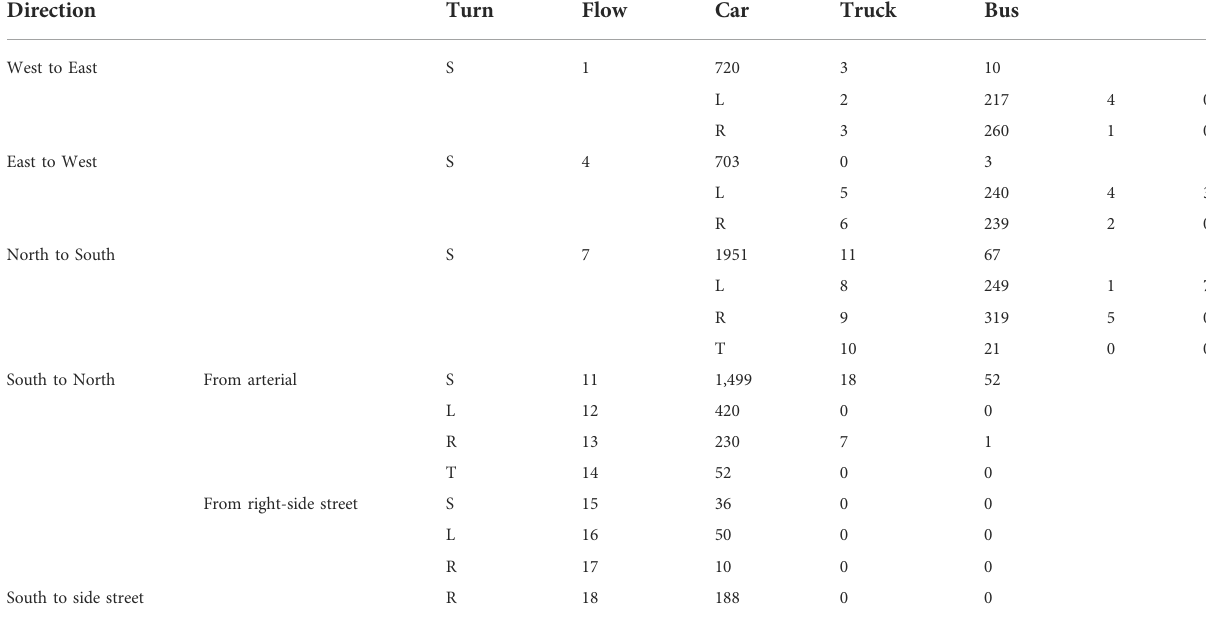
TABLE 1 Collected data during one peak hour (6:30 p.m. – 7:30 p.m.) on